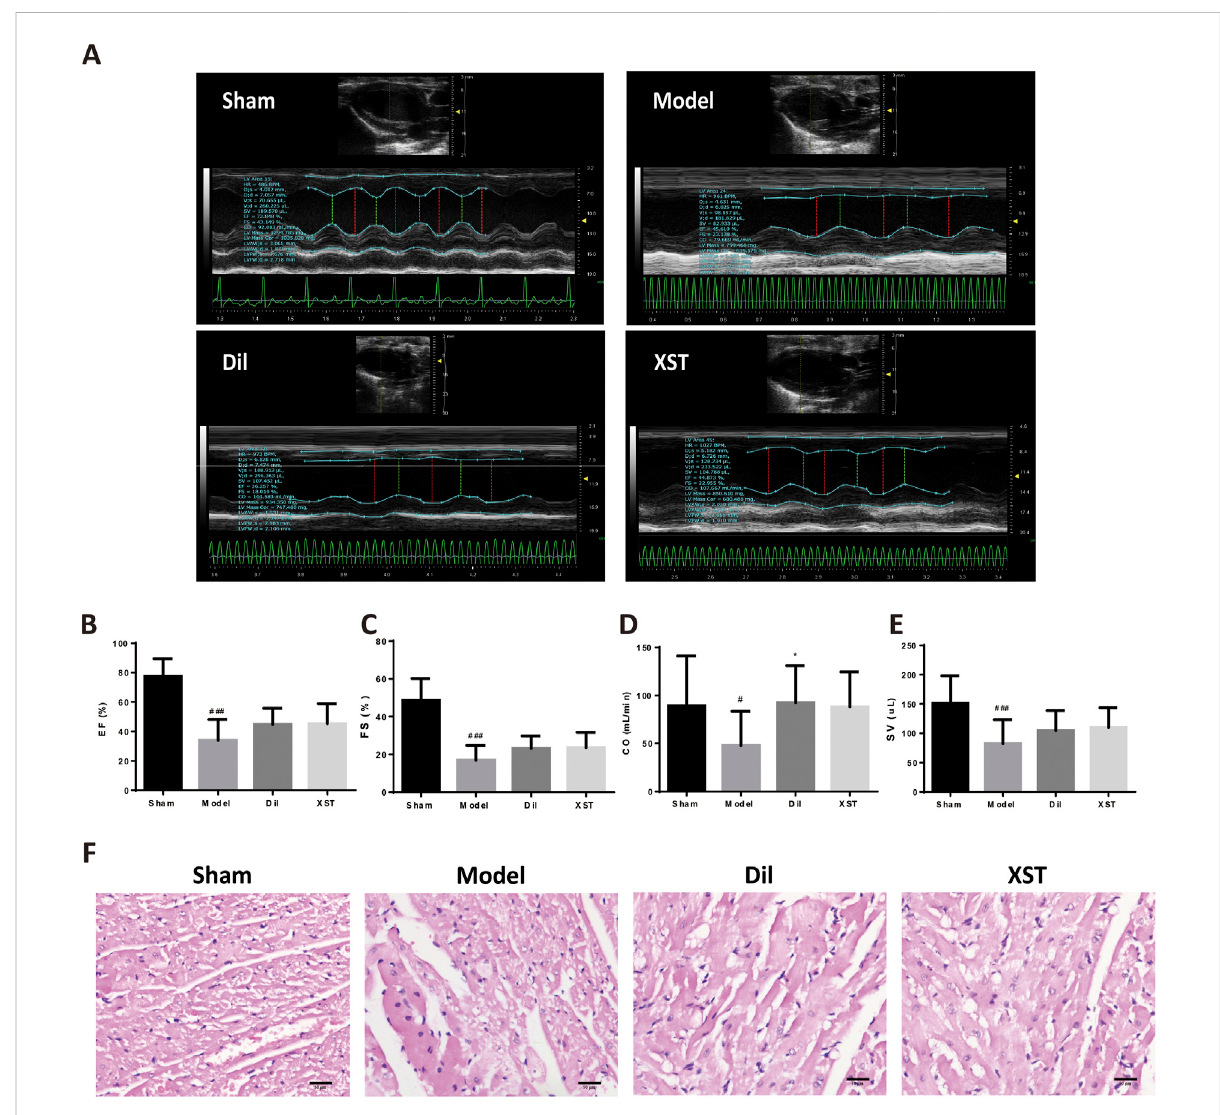
FIGURE 4 Effect of XST on cardiac function and myocardial histology in the AMI rat in 20 min. (A) Representative echocardiograph from the various groups. The values of EF (B) , FS (C) , CO (D) , and SV (E) in various groups, n = 8 – 13. (F) Representative HE-stained images in the sham (f1), model (f2), Dil (f3), and XST (f4) groups. The panel was captured at ×40 magni fi cation of the objective. Bar = 50 μ